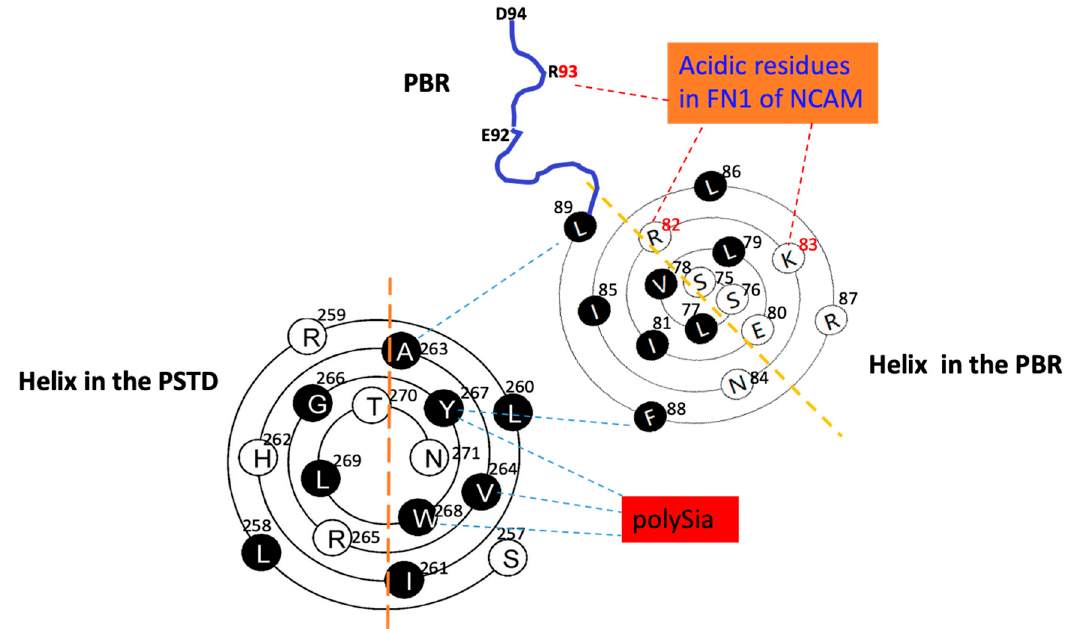
Figure 4. The system schematic of the relative position and interactions of the PSTD-polySia, PBR- FN1 and the PSTD-PBR using the helical wenxiang diagrams of the PSTD and the PBR, respectively. Actually, it is a combination of Figure 2a,c.